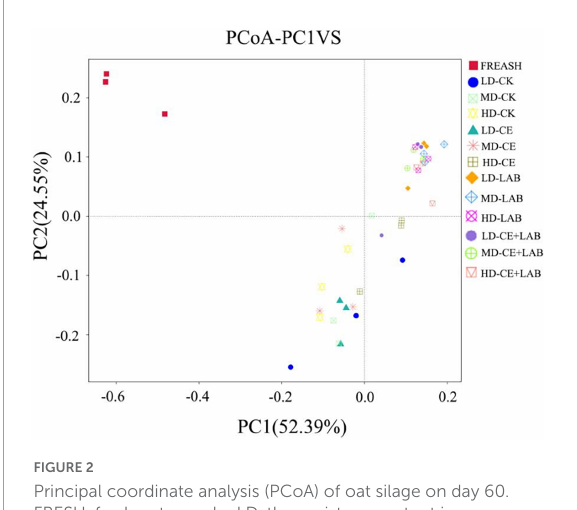
FIGURE2 Principal coordinate analysis (PCoA) of oat silage on day 60. FRESH, fresh oat sample; LD, the moisture content is approximately 67%; MD, the moisture content is approximately 75%; HD, the moisture content is approximately 81%; CK, control, no additive; LP, L. plantarum ; CE, cellulase; LP+CE, combination of L. plantarum and cellulase.